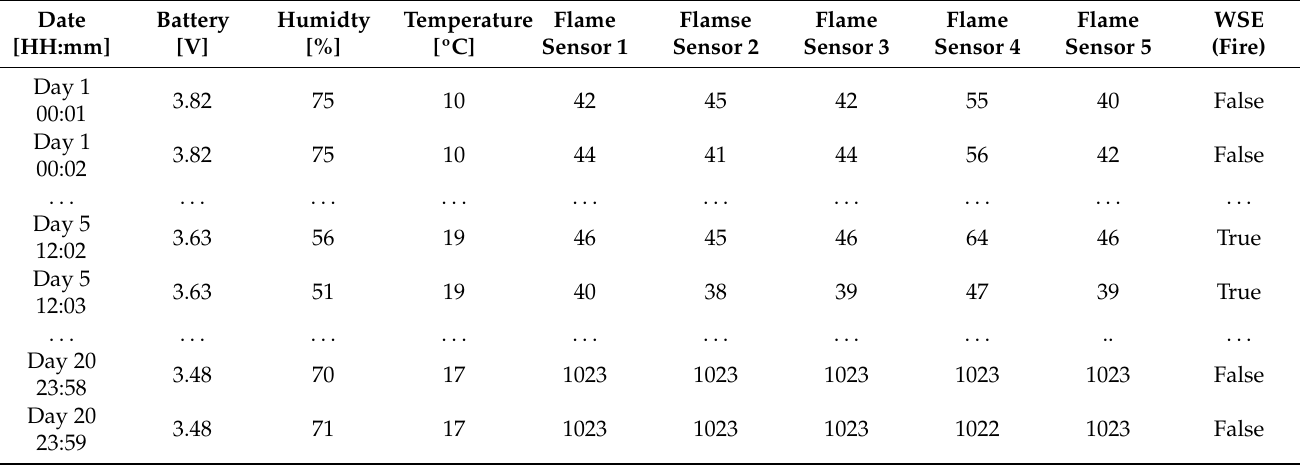
Table 2. Demonstration of the dataset’s structure generated by a given sensor module stored on the server after the four